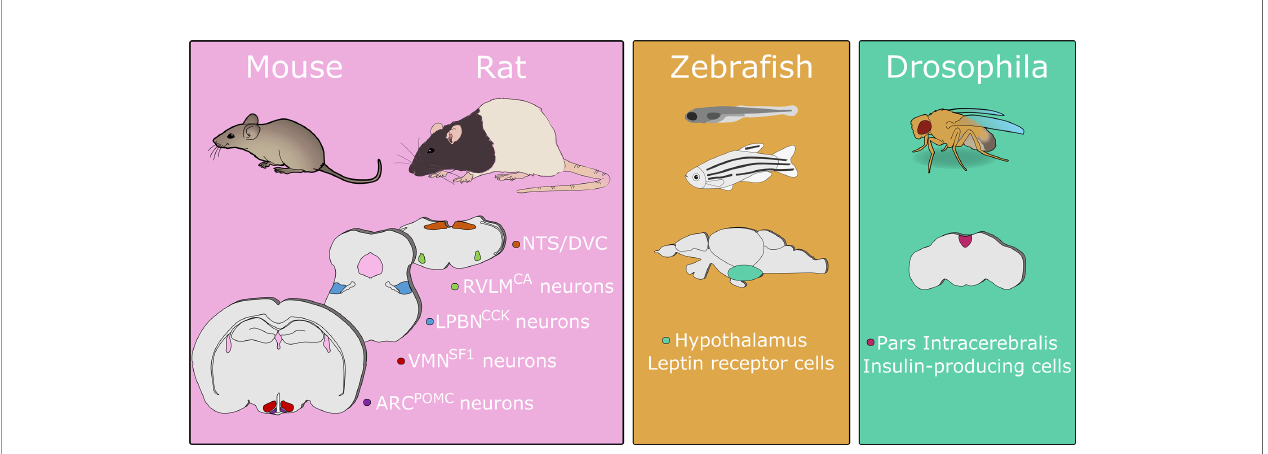
FIGURE 1 | A simpli fi ed overview of primary brain sites regulating blood glucose identi fi ed in model organisms. This fi gure shows the cell populations discussed in this review and is not an exhaustive list. Numerous brain regions have been demonstrated to contribute to glucose regulation in mice and/or rats. In zebra fi sh disruption of leptin receptor signaling induces hyperglycemia. In drosophila, ablation of insulin-producing cells causes increases in hemolymph carbohydrate levels. Abbreviations: ARC, arcuate nucleus of the hypothalamus; CA, catecholamine; CCK, cholecystokinin; DVC, dorsal vagal complex; LPBN, lateral parabrachial nucleus; NTS, nucleus of the solitary tract; POMC, pro-opiomelanocortin; RVLM, rostral ventrolateral medulla; SF1, steroidogenic factor 1; VMN, ventromedial nucleus of the hypothalamus. Animal images adapted from Scidraw.io. Drawings not to